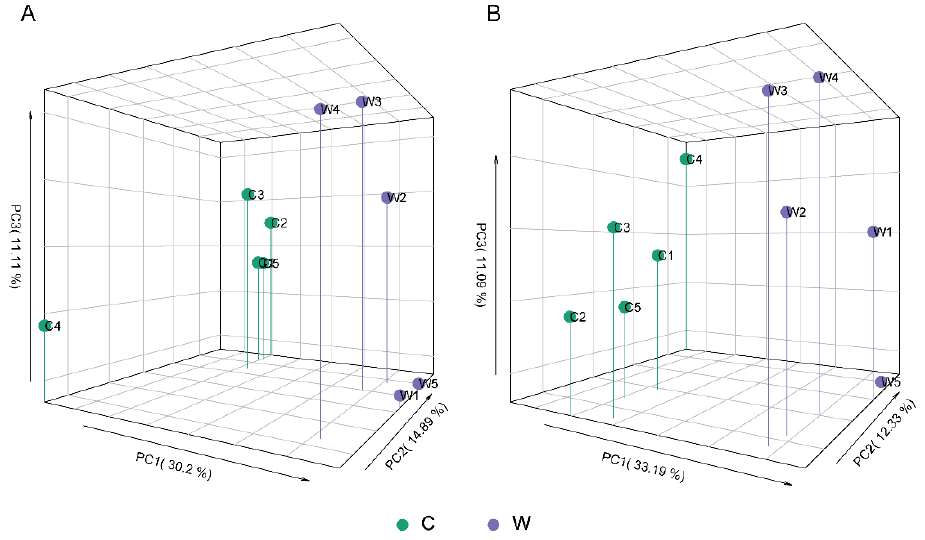
Figure 2. PCA score plots of the metabolites acquired from positive ( A ) and negative ( B ) ionization modes.